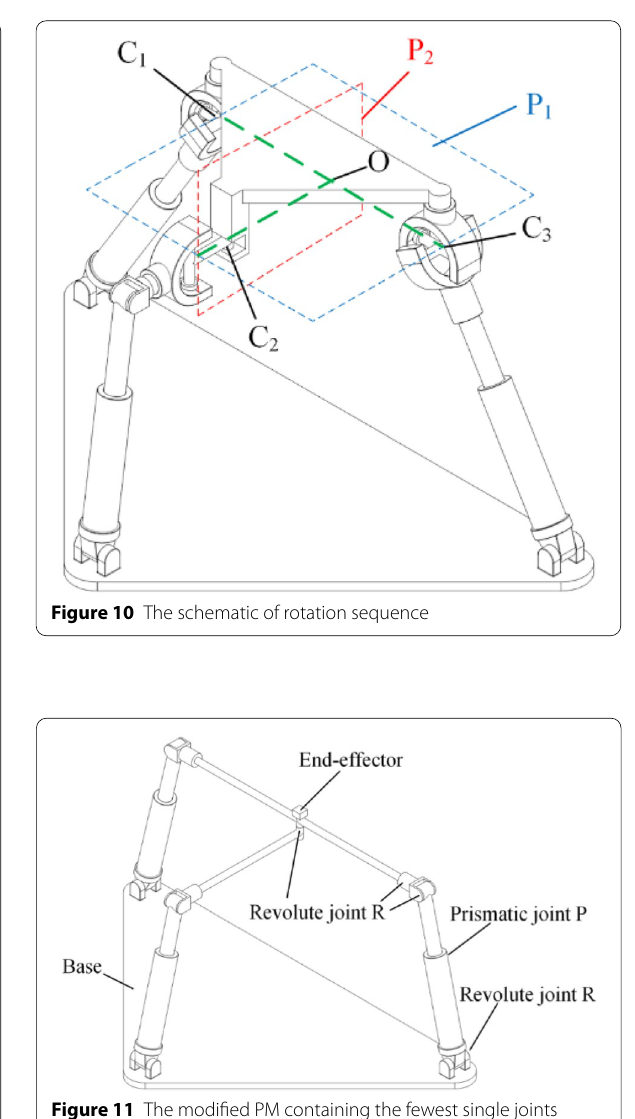
structures, the modified PM shown in Figure 11 contains